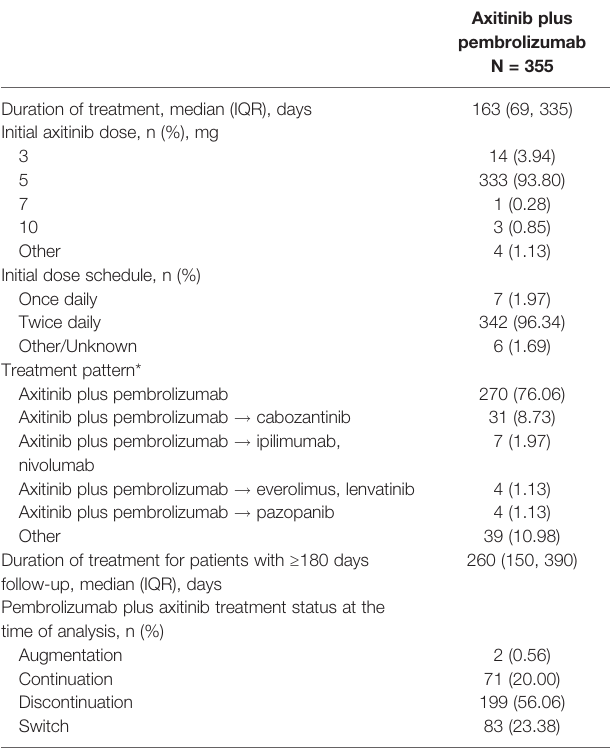
TABLE 2 | Treatment characteristics.